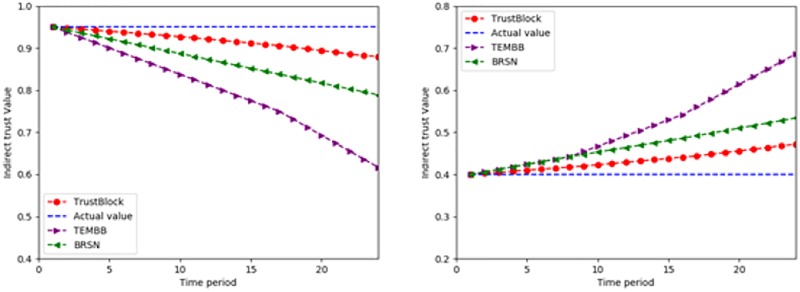
Malicious recommendation value filtering.(a) Normal node indirect trust value filtering. (b) Untrust node indirect trust value filtering.